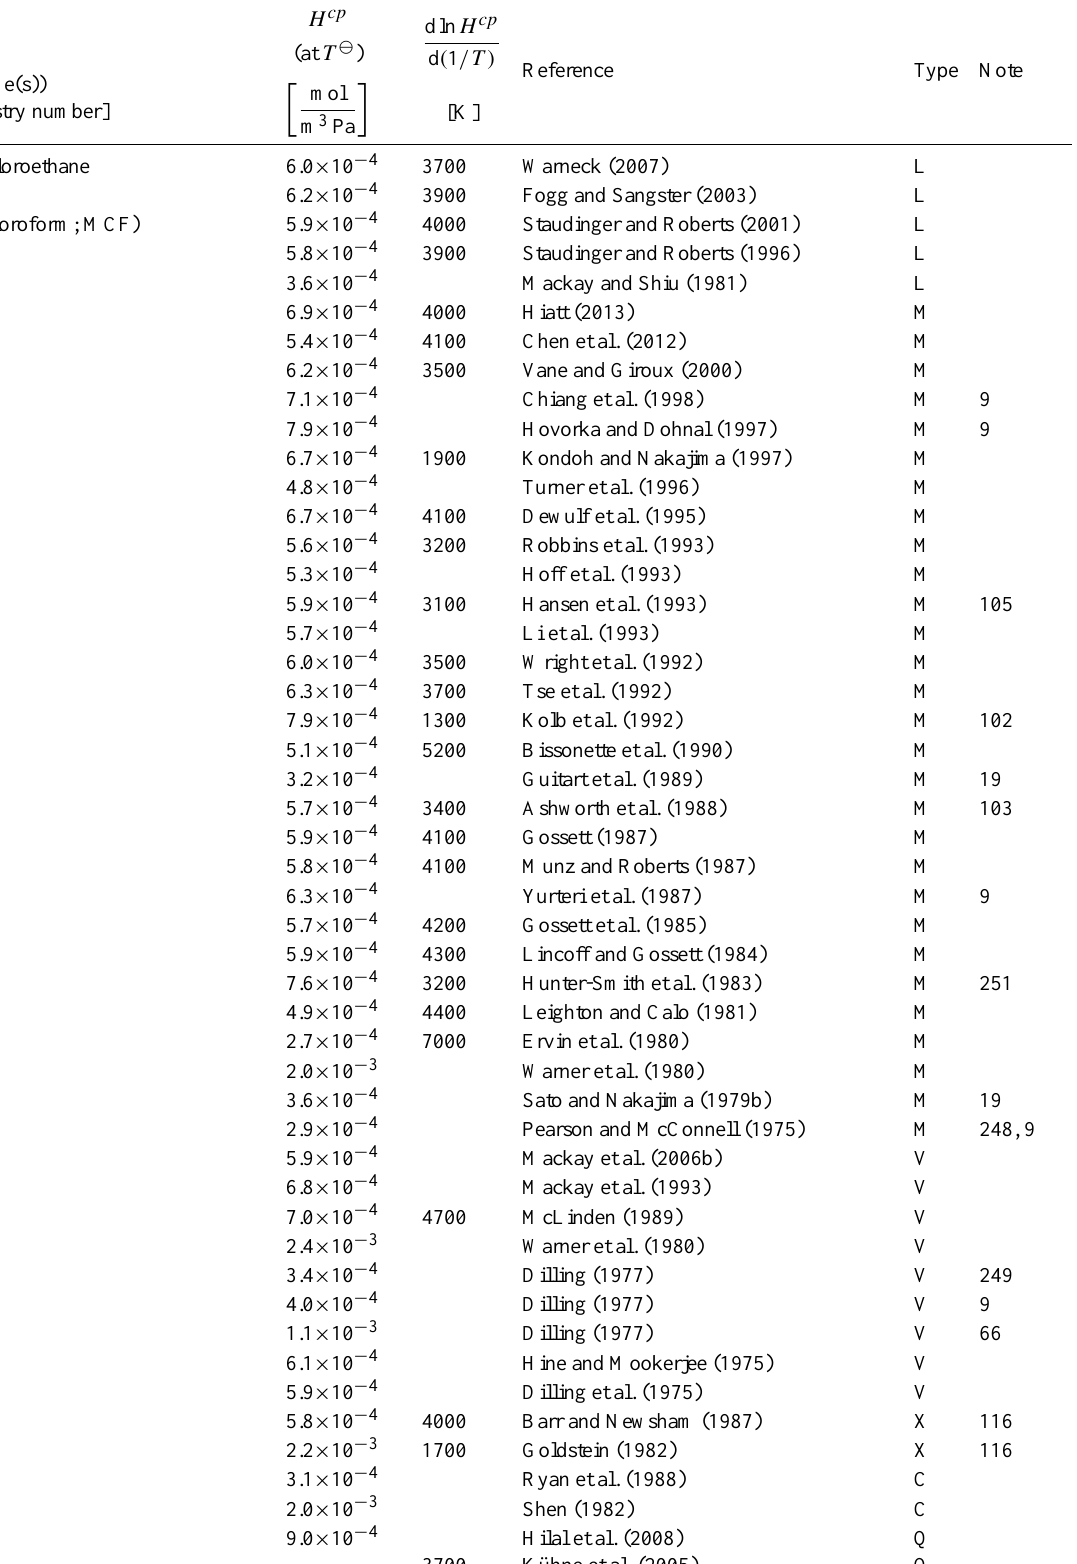
Table 6: Henry’s law constants for water as solvent